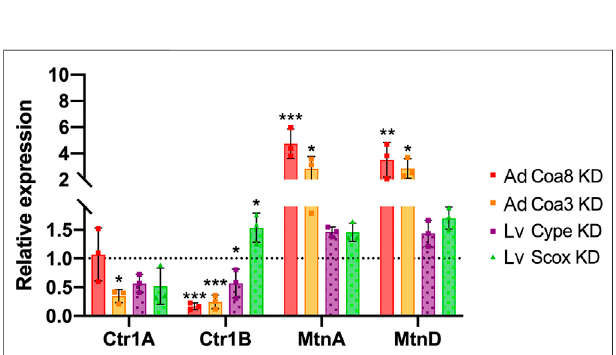
FIGURE 4 | COX de fi ciency alters the expression of metal-responsive transcription factor 1 (MTF-1) target genes. Transcript levels measured by quantitative PCR of the copper transporters Ctr1A , Ctr1B, and the metallothioneins MtnA , MtnD in different genetic models of COX de fi ciency. Expression levels are normalized to the expression in the control strains (set to 1). Genotypes are: Coa8 KD (solid red bars), Coa3 KD (solid orange bars), cype KD (dotted purple bars) and Scox KD (dotted green bars). The bars represent the mean ± SD of n = 3 biological replicates, each measured in triplicate. One-way ANOVA and Dunett ’ s multiple comparison test of KD vs. control (* p ≤ 0.05, ** p ≤ 0.01 *** p ≤ 0.001). Ad: Adults; Lv: